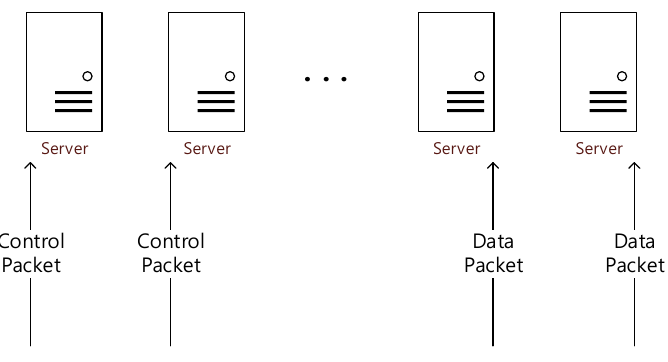
Figure 10. Example of a static partition environment.